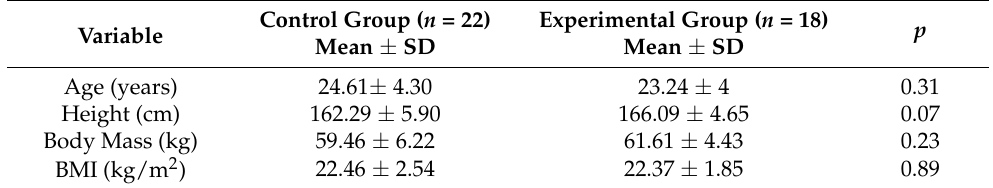
Table 1. Descriptive data of the